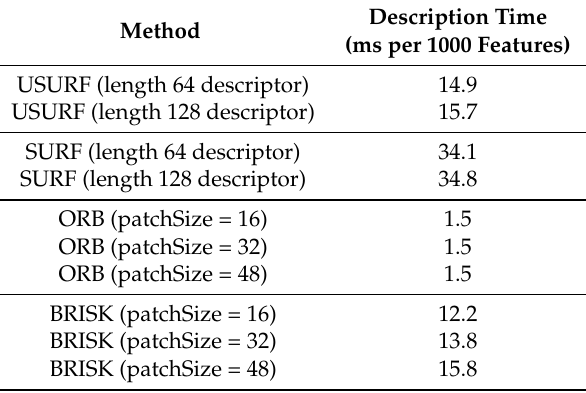
Table 6. Average processing time per feature on an Intel core i5-4590 CPU for various methods of feature